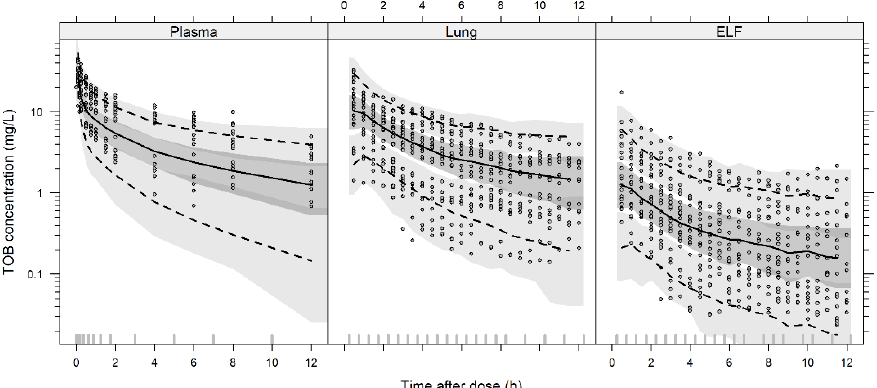
Figure 2. Predicted-corrected visual predictive check of the final popPK model stratified by plasma, lung, and ELF. VPCs are based on 1000 simulations and show a comparison of the observations (dots) with the 10th, 50th, and 90th percentiles of the 1000 simulated profiles (dashed lines and shadow areas).